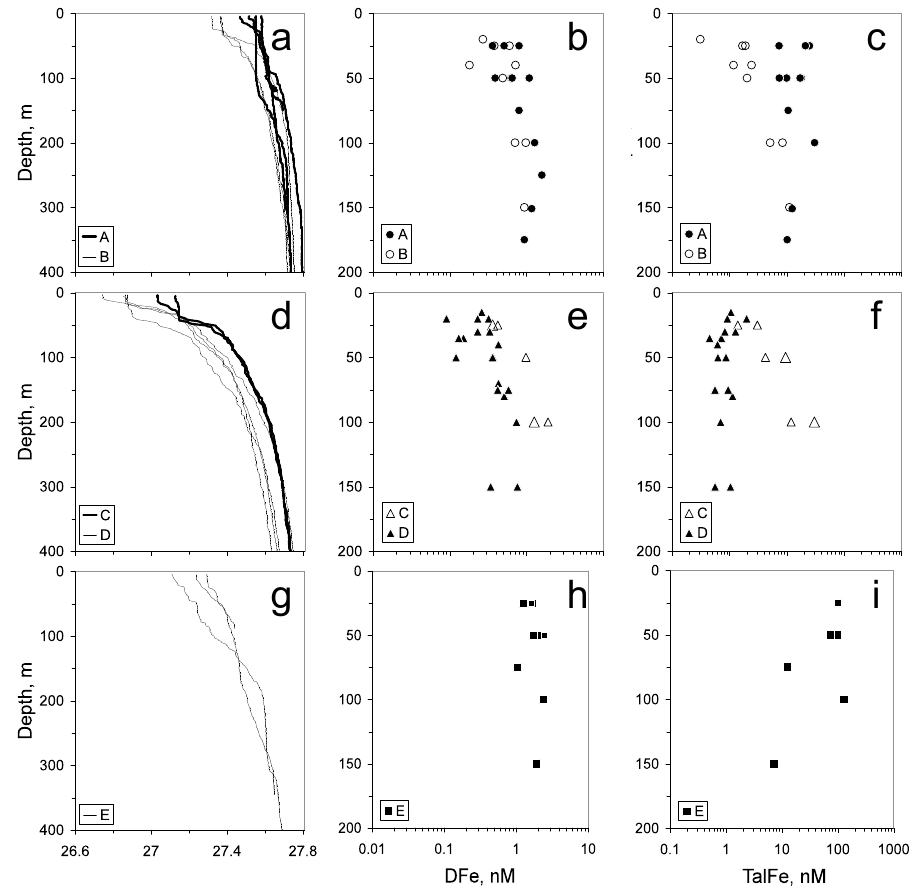
Fig. 4. Water density and Fe concentrations relative to water depth. Profiles show density (sigma-q; a, d, g ), dissolved Fe concentrations (b, e, h) , and total acid leachable Fe (c, f, i) . Stations in groups A( • ) and B ( ◦ ) are shown in (a), (b), (c); Stations in groups C ( 4 ) and D ( N ) are shown in (d), (e), (f); Stations in groups E ( (cid:4) ) are shown in (g), (h), (i). The stations within each of these five groups are listed in Table